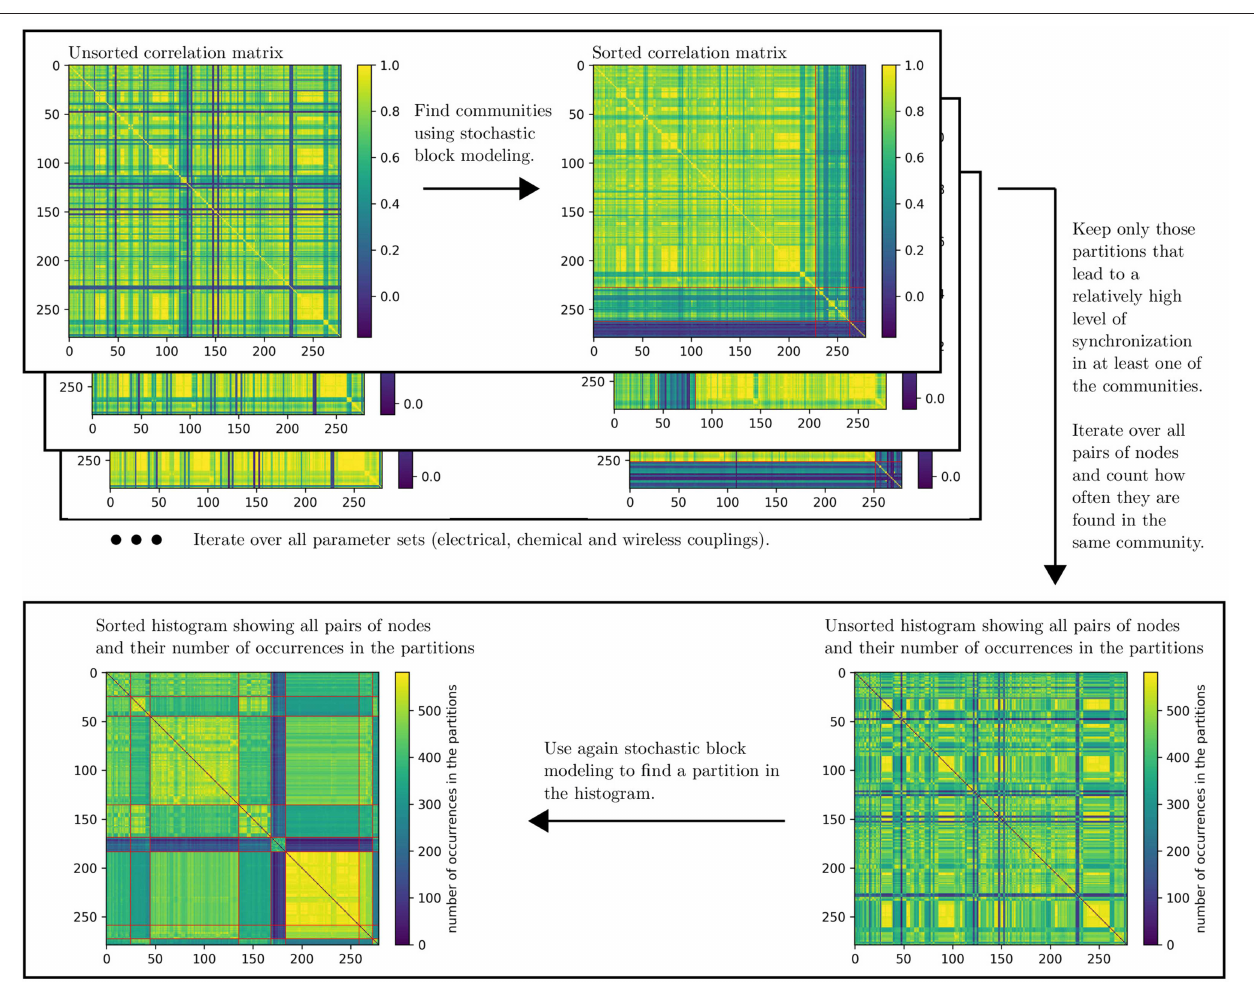
FIGURE 12 | Schematic description of the dynamical correlation-based community detection algorithm. In the sorted matrices red lines represent the borders between two